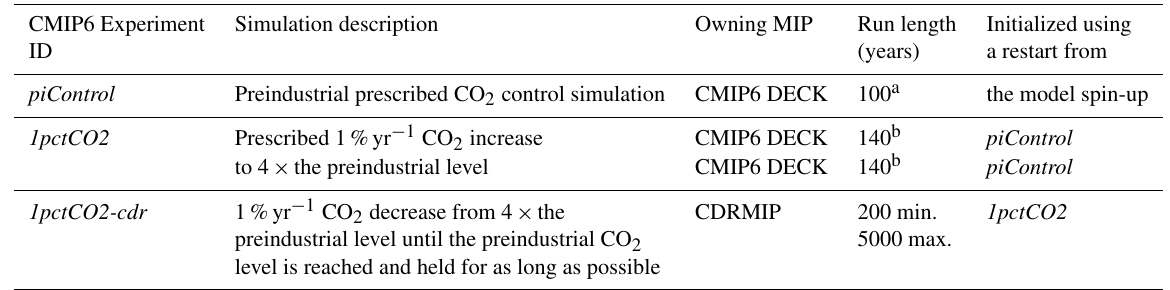
Table 2. Climate and carbon cycle reversibility experiment ( CDR-reversibility ) simulations. All simulations are required to complete the experiment.